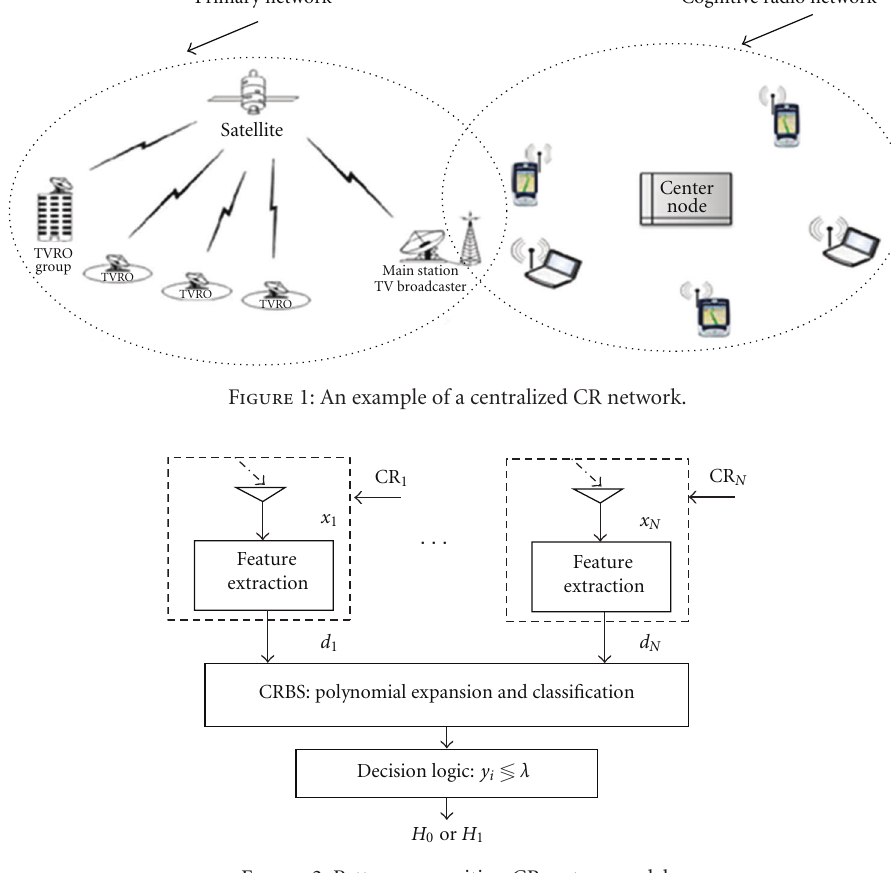
Figure 2: Pattern recognition CR system